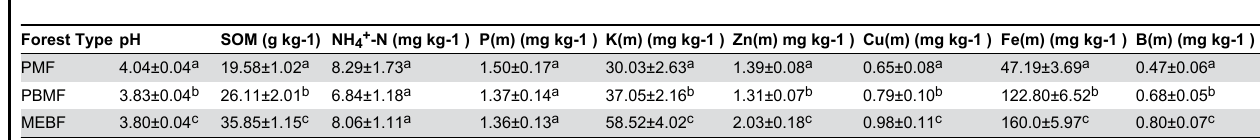
Table 2. Effect of natural succession on selected soil chemical properties (numbers represent mean values±standard error).